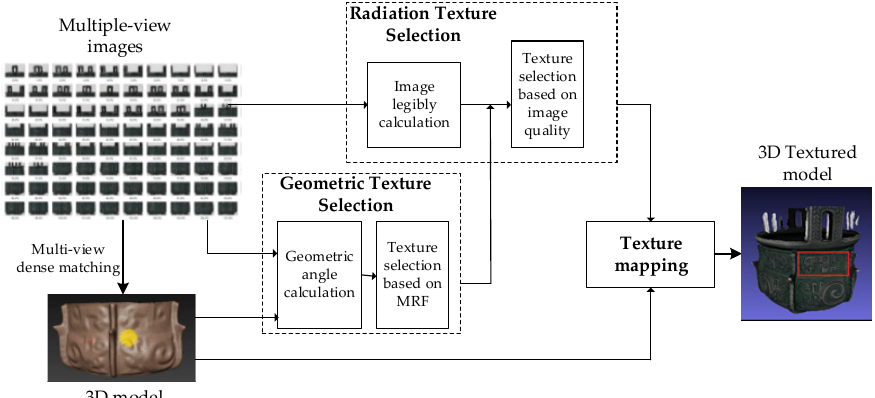
Figure 1. Technical flowchart of the proposed approach.